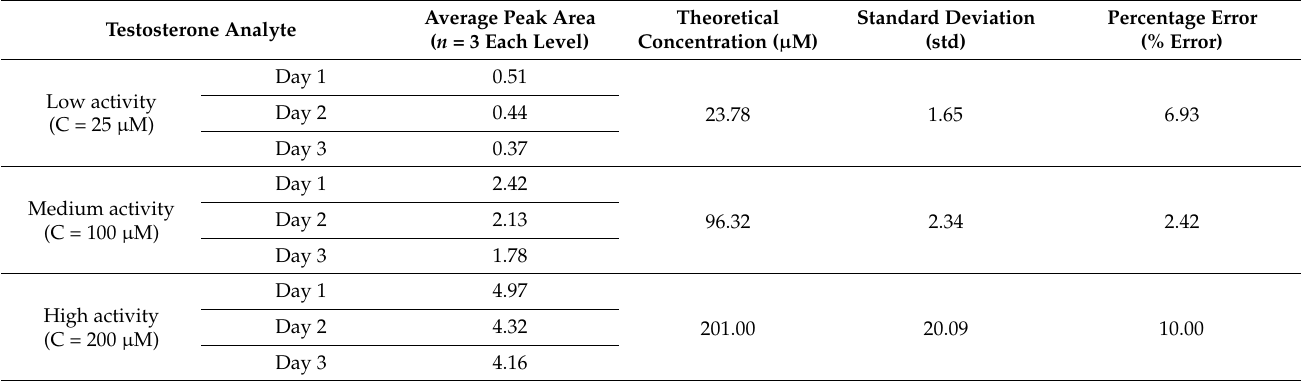
Table 9. Testosterone inter-assay precision data.